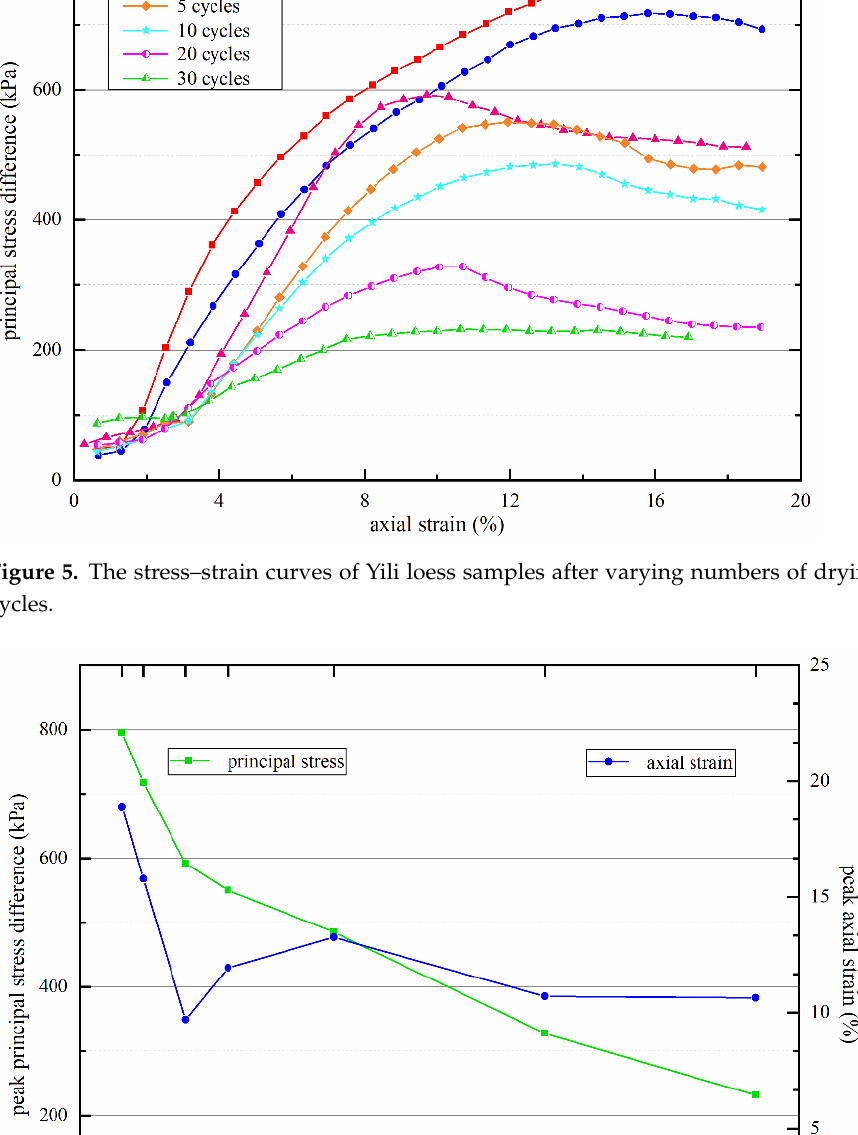
Table 5. Shear strength parameters.